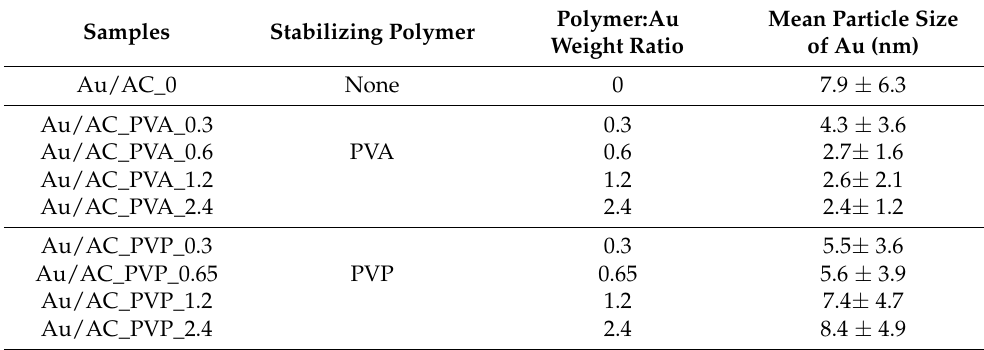
Figure 1. Representative STEM-HAADF images of ( a ) Au/AC (PVA/Au = 0 w / w ) and ( b ) Au/AC (PVA/Au = 2.4 w / w ). Table 1. Mean particle size for supported Au nanoparticles using PVA and PVP with different polymer to Au weight ratio as determined by TEM analysis.